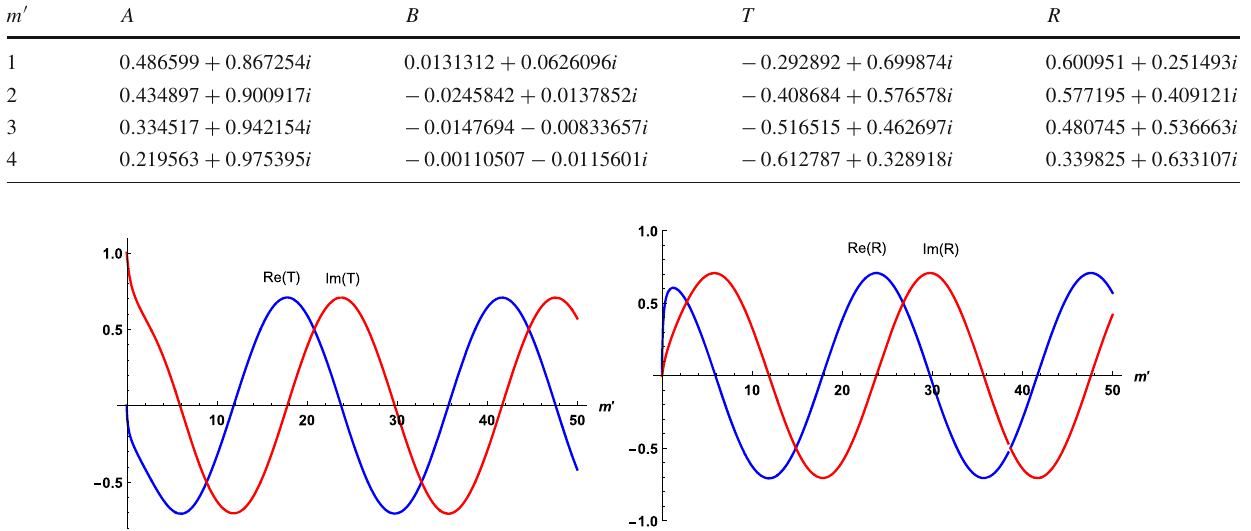
Fig. 3 The m (cid:2) -dependence of the transmission coefficient T and reflection coefficient R in the scattering with real momentum scenario